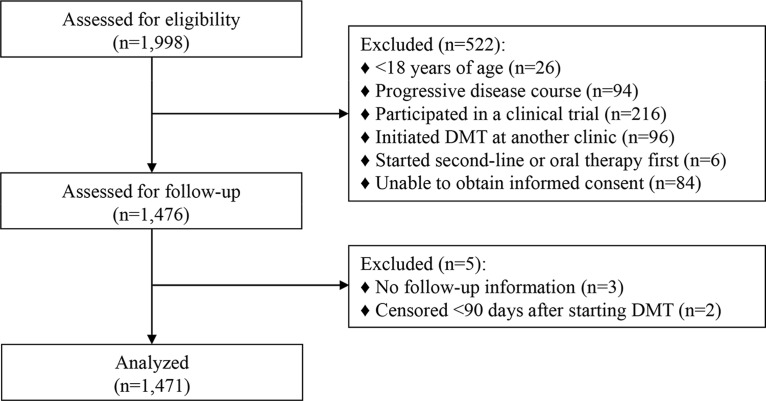
Flow diagram of patient selection into the study cohort.